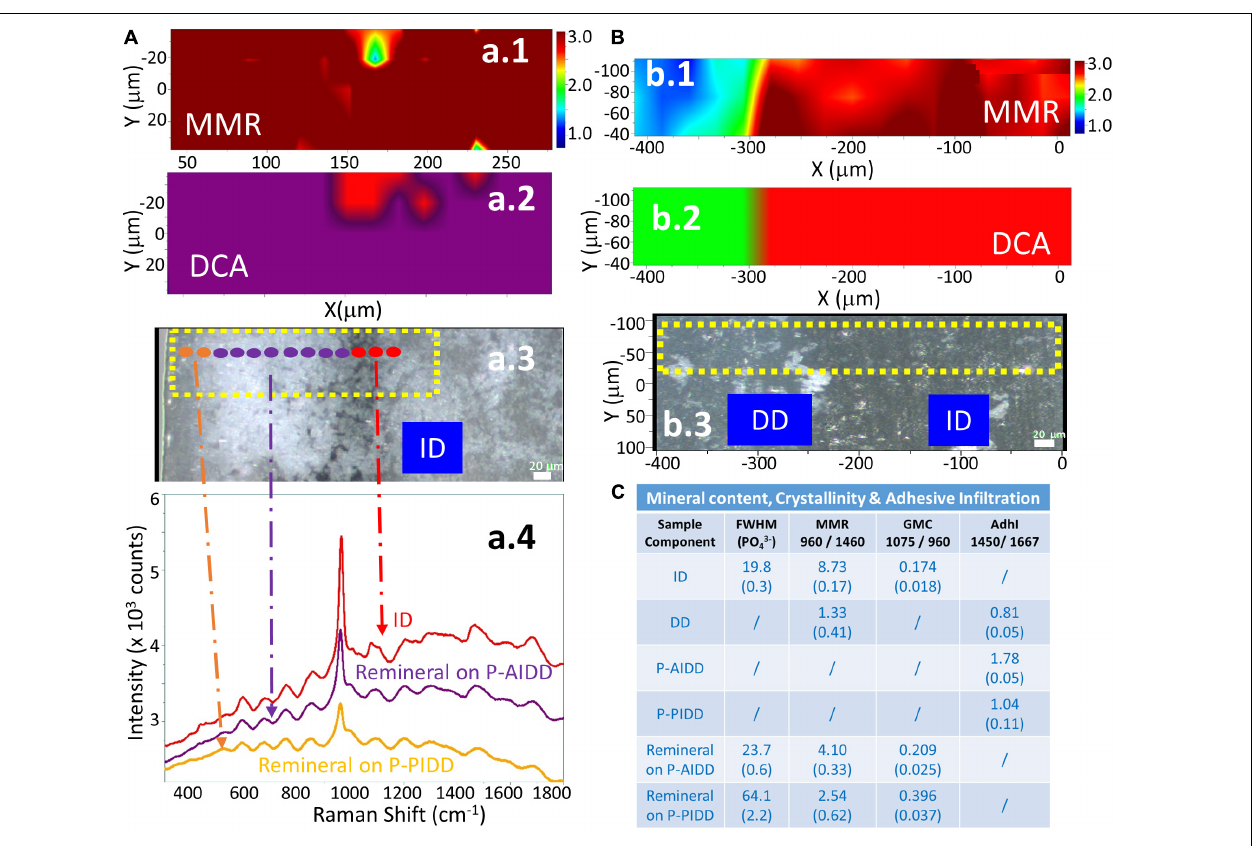
FIGURE 5 | RAMAN analysis of a representative peptide-functionalized adhesive-infiltrated demineralized dentin (P-AIDD) specimen after remineralization (A) and a control demineralized dentin (DD) specimen after remineralization protocol (B) . (a.1,b.1) µ -Raman mineral map (MMR) of the X-Y scan area. Blue represents the lowest ratio, while red represents the highest. (a.2,b.2) K-means clustering map (DCA) of the Raman profile of the same sample. (a.3,b.3) Visible images of the scanned areas. Scale bar is 20 µ m. (a.4) Raman spectra of principal components (PCs) from the DCA. (C) Summary of the Raman spectral features related to quantification of mineral content, crystallinity, and adhesive infiltration to the dentin samples before and after